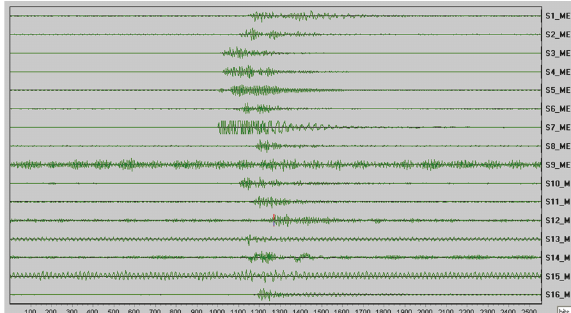
Figure 10: Waveforms of the blasting event.